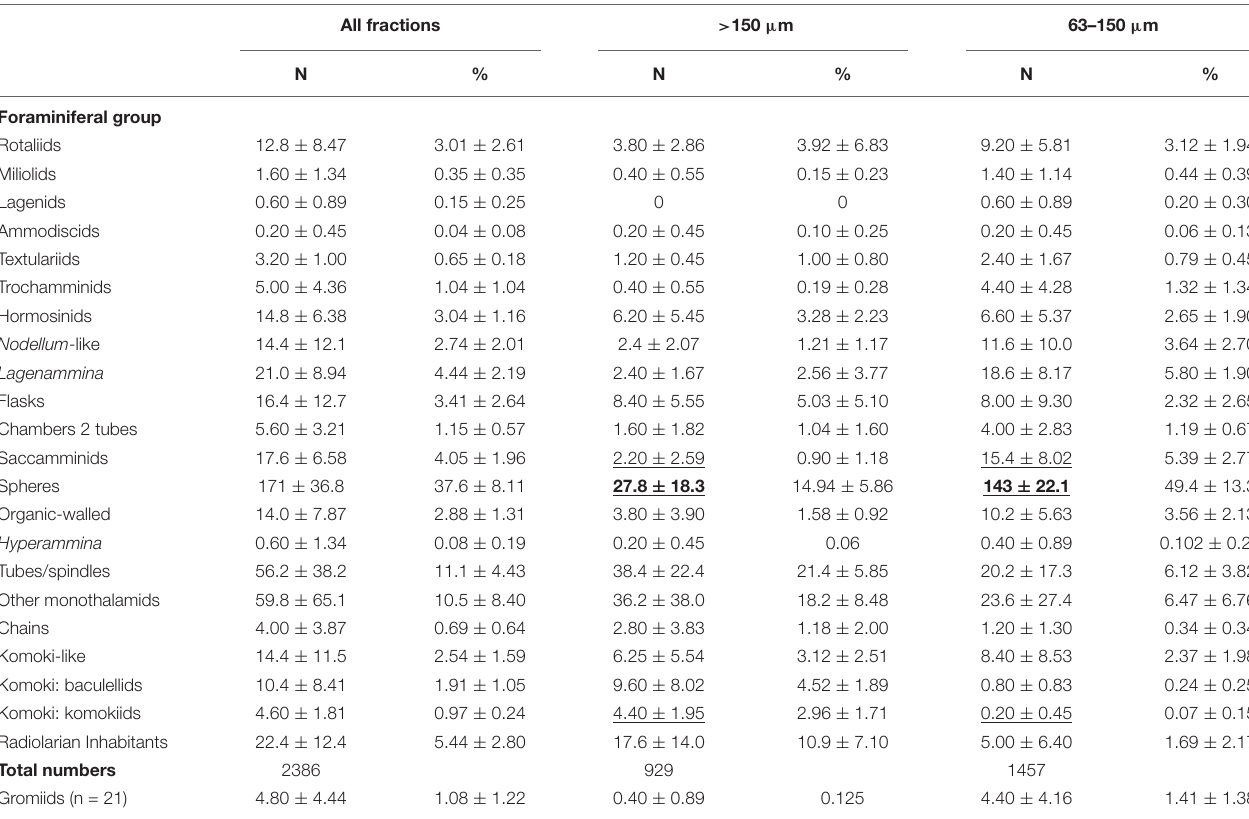
TABLE 3 | Mean and percentage abundances ( ± standard deviations) of major groups based on complete stained specimens in the two size fractions and both fractions combined of 5 samples. All